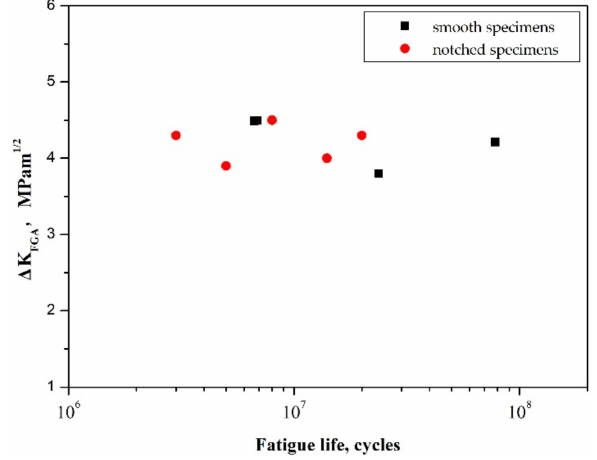
Figure 15. Relationship between the stress intensity factor range at the FGA and fatigue